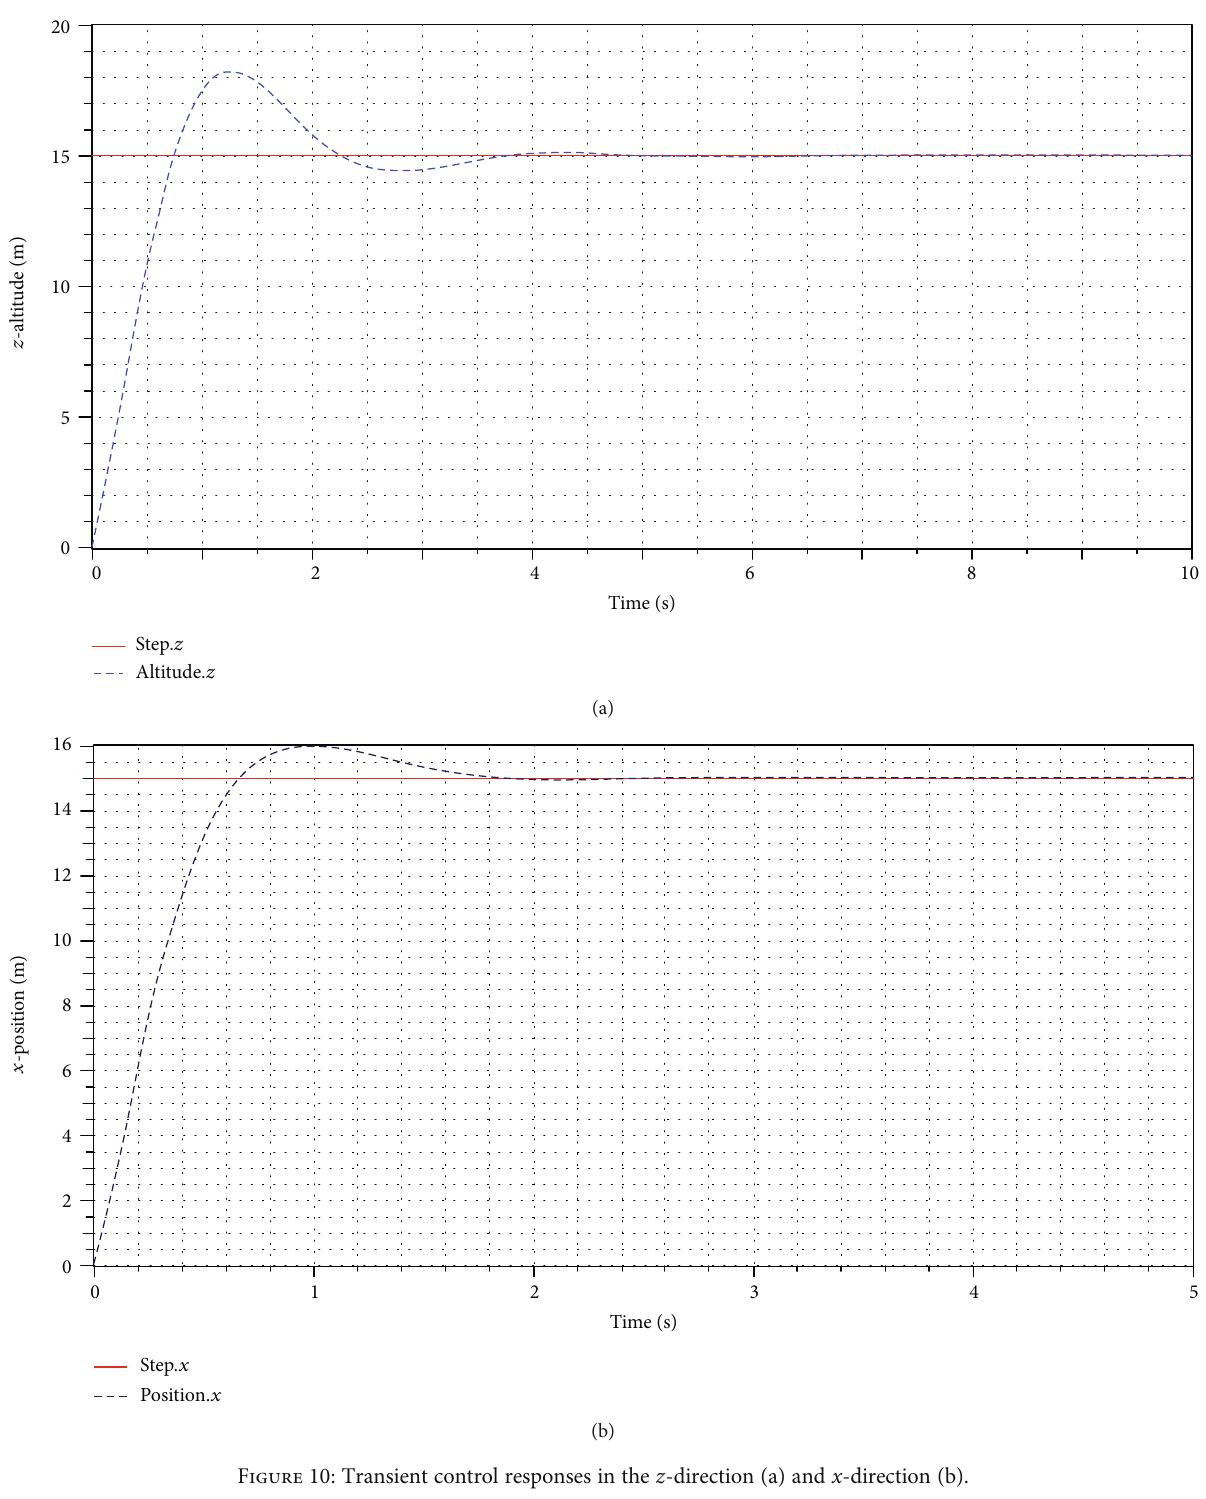
Figure 10: Transient control responses in the z -direction (a) and x -direction